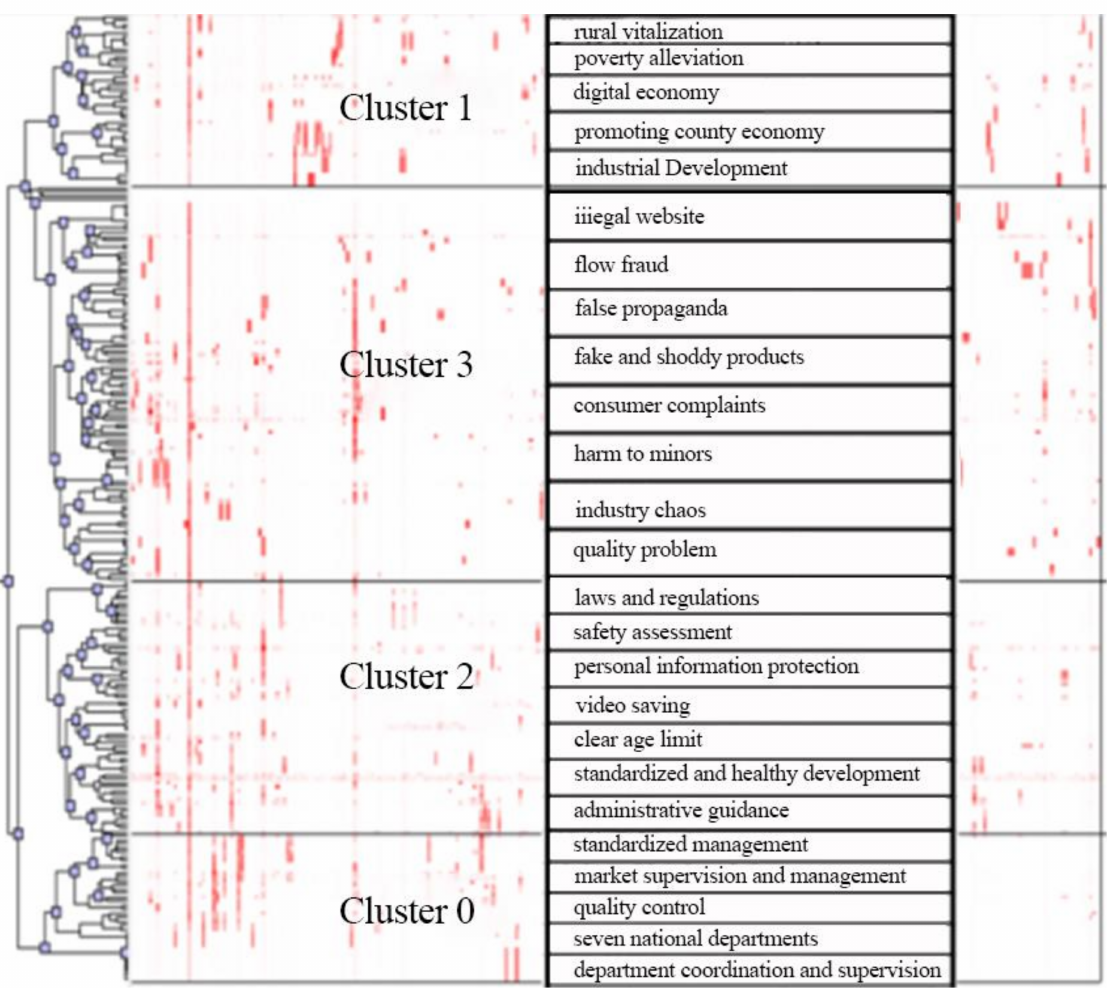
Figure 4. Clustering results of live streaming